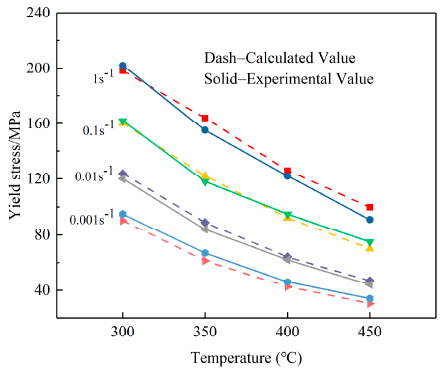
Figure 7. Comparison between experimental and calculated flow stress values of W / 2024Al composites at high temperatures with different strain rates.